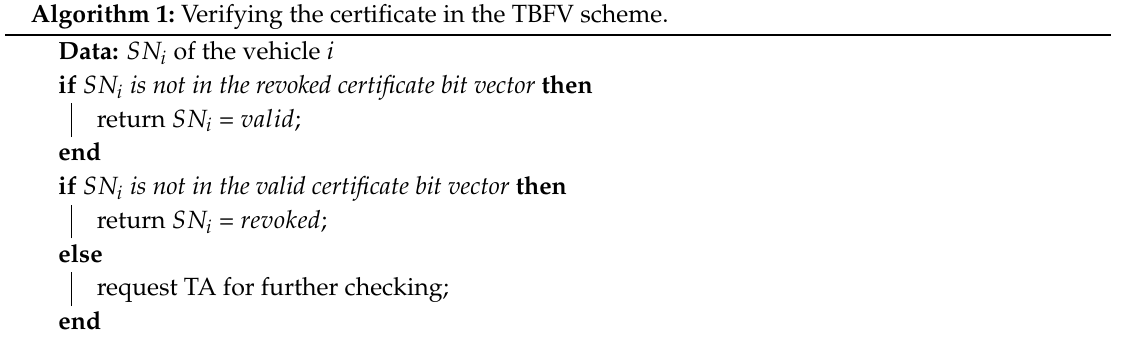
Algorithm 1: Verifying the certificate in the TBFV scheme. Data: SN i of the vehicle